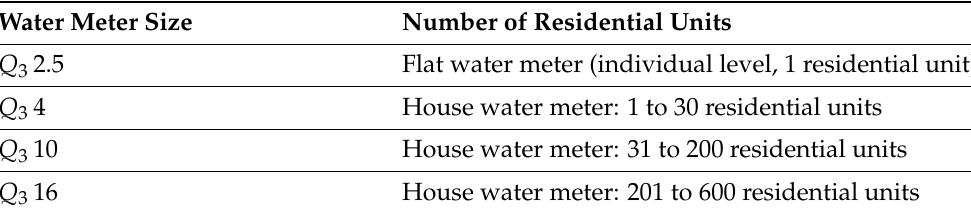
Table 2. Design limits for residential buildings according the guideline DVGW-W-406